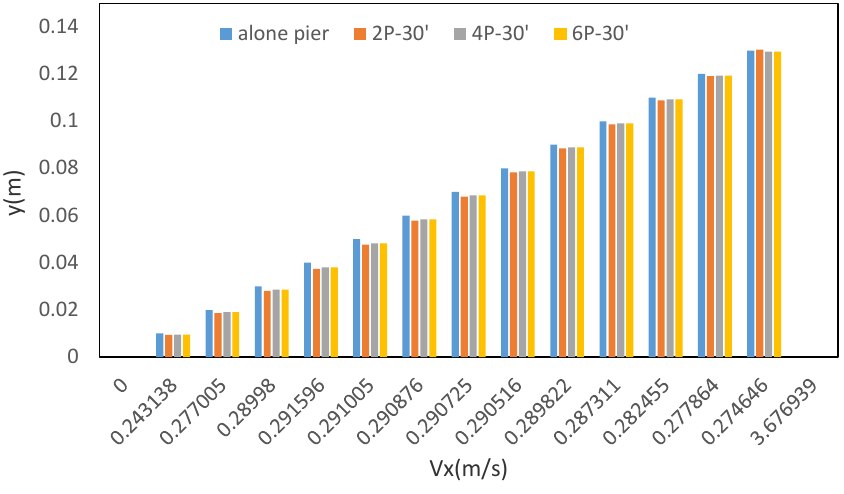
Fig 16. Comparison of the horizontal velocity component in 𝛼 = 30˚ , 𝑍 =